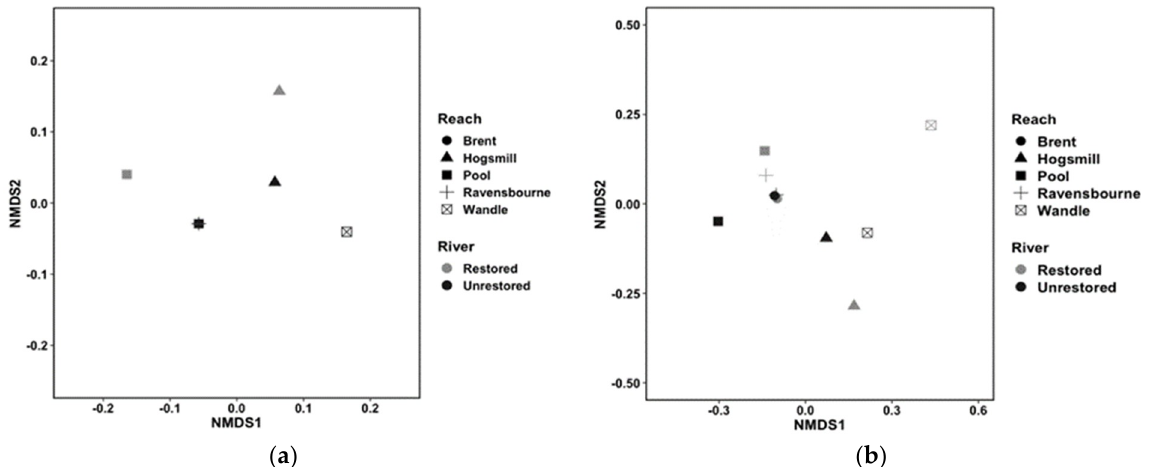
Figure 5 . Plots of non-metric multidimensional scaling (NMDS), highlighting community clustering between rivers and reaches for ( a ) density and ( b ) biomass.